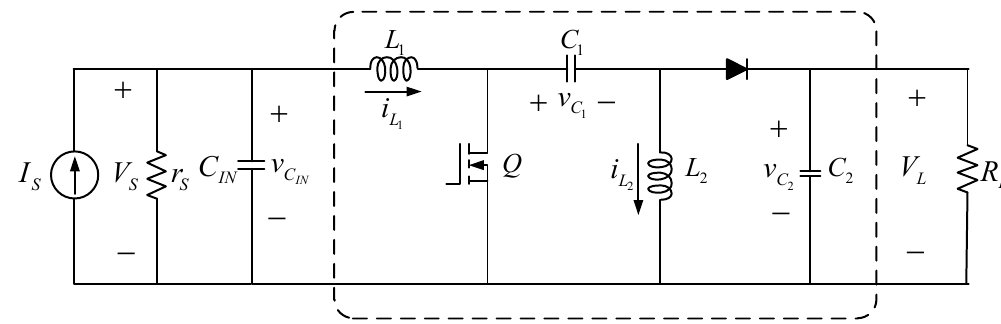
Figure 3. The current-fed SEPIC buck-boost converter